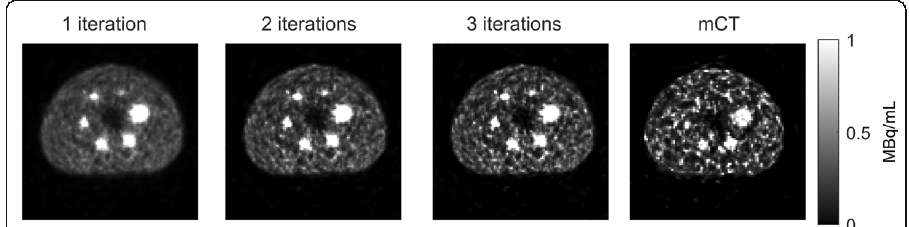
Fig. 2 Transverse slice of three Vision reconstructions (1, 2, and 3 iterations with 5 subsets) and mCT reconstruction (2 iterations with 21 subsets) of the NEMA phantom at day 0 (2.5·10 3 MBq), centred on the spheres. Images are scaled between 0 and 1 MBq/mL